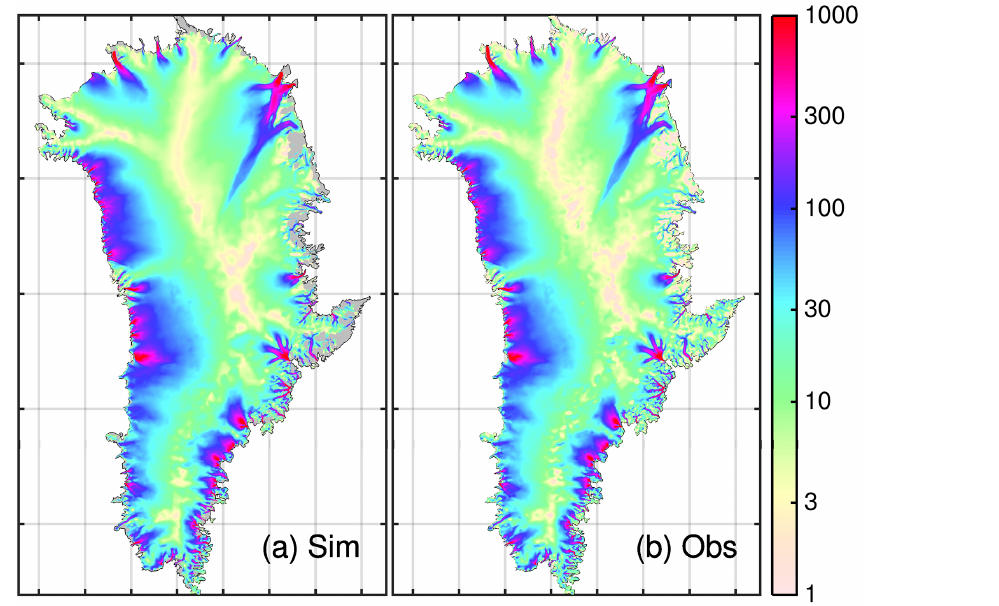
Figure 9. Present-day velocities (year 2000) using SEMIC-HadGEM2: (a) observed velocities, (b) simulated velocities. Observed velocities: Rignot and Mouginot